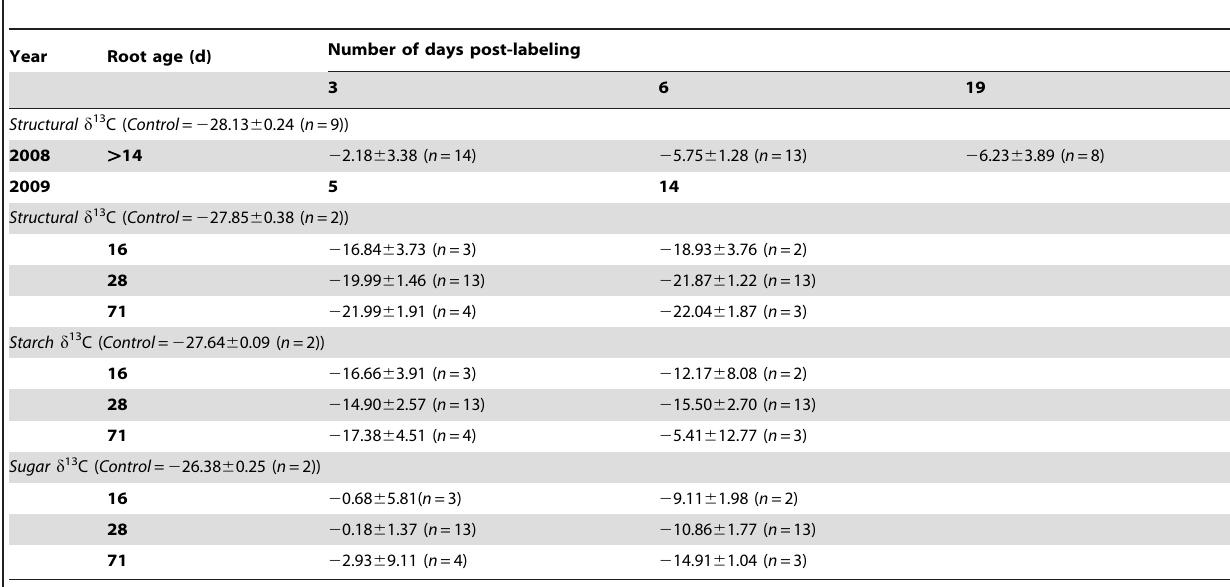
Table 1. Sassafras albidum d 13 C root data from trees labeled with 99% 13 CO 2